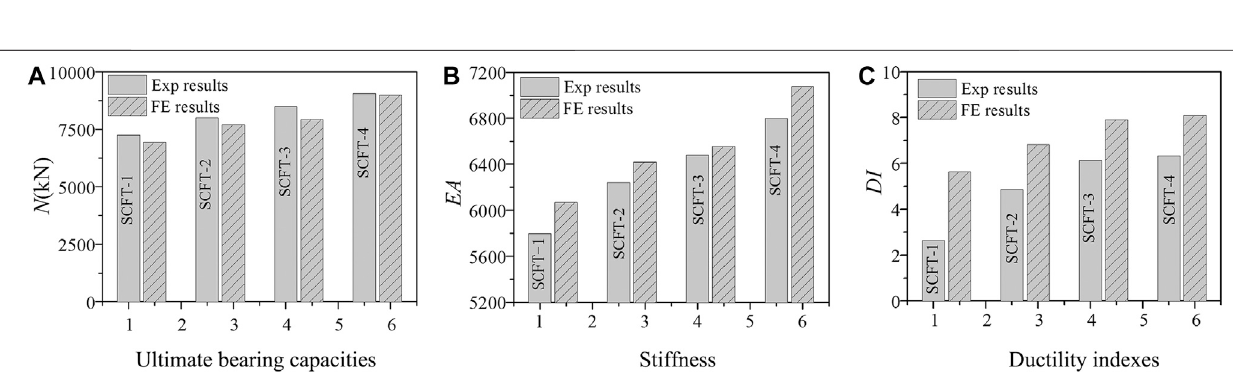
FIGURE 5 | Comparison of load-strain curve of FE calculation results and test results.